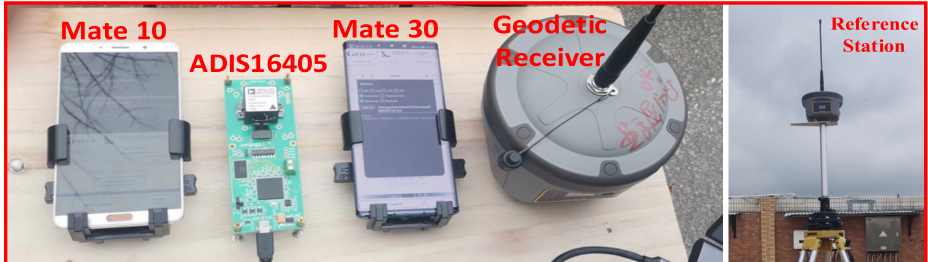
Figure 1. View of the experiment devices. Left: Huawei Mate 10, triaxial inertial sensor ADIS16405, Huawei Mate 30, and South geodetic receiver. Right: the reference station is placed in the open area on the roof.